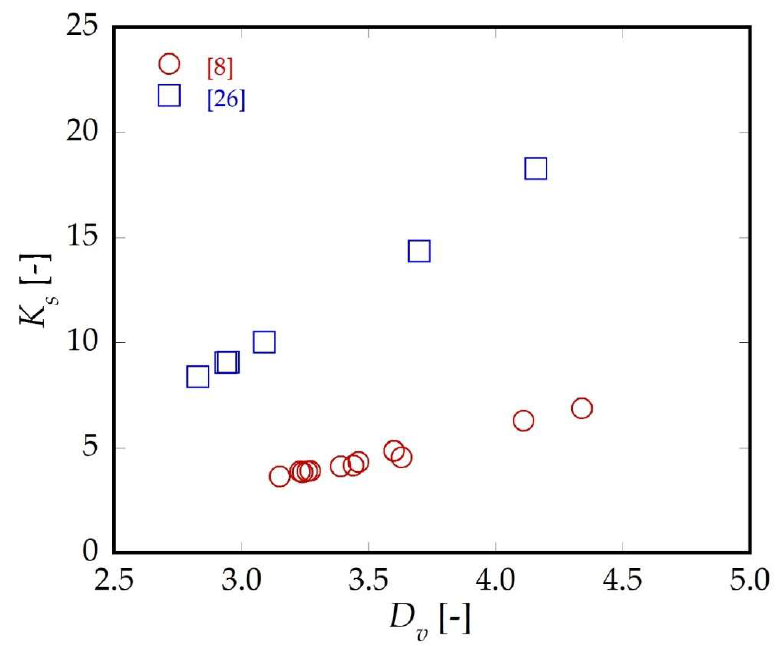
Figure 4. Variation of the head loss coefficient K s as a function of the drop parameter D v for vortex drop shafts. drop